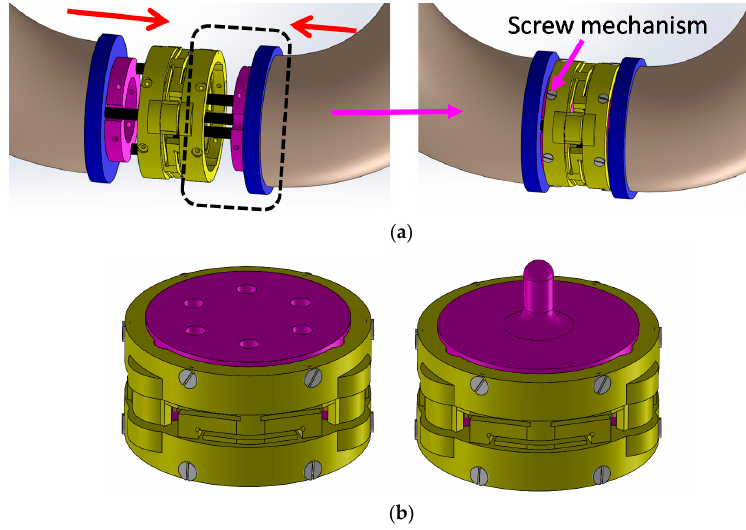
Figure 5. Screw mechanism of three-axis force torque sensor: ( a ) The STIFF-FLOP manipulator with screw mechanism; ( b ) Three-axis force/torque sensor ( left ) and three-axis force sensor ( right ) with screw mechanism